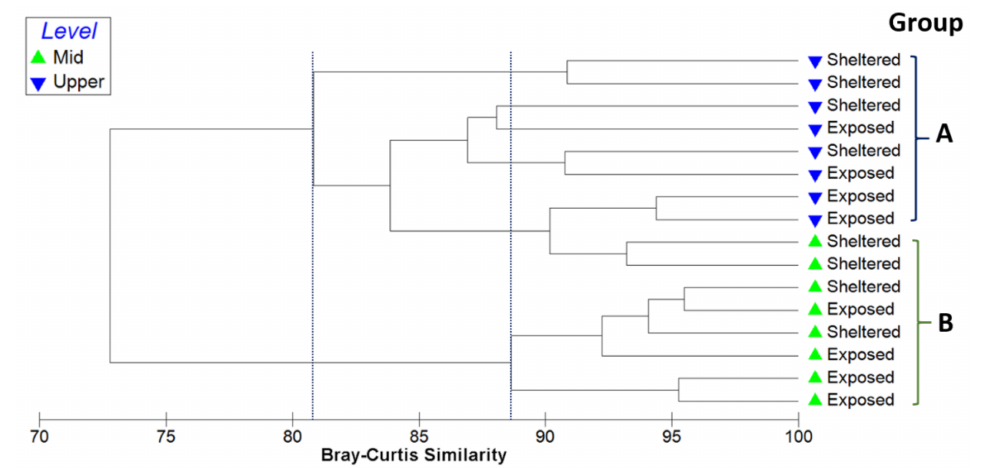
Figure 11. Dendrogram for hierarchical clustering of C. stellatus population cover at the study sites and shore levels using group-average clustering of Bray–Curtis similarities based on square root-transformed cover percentages.